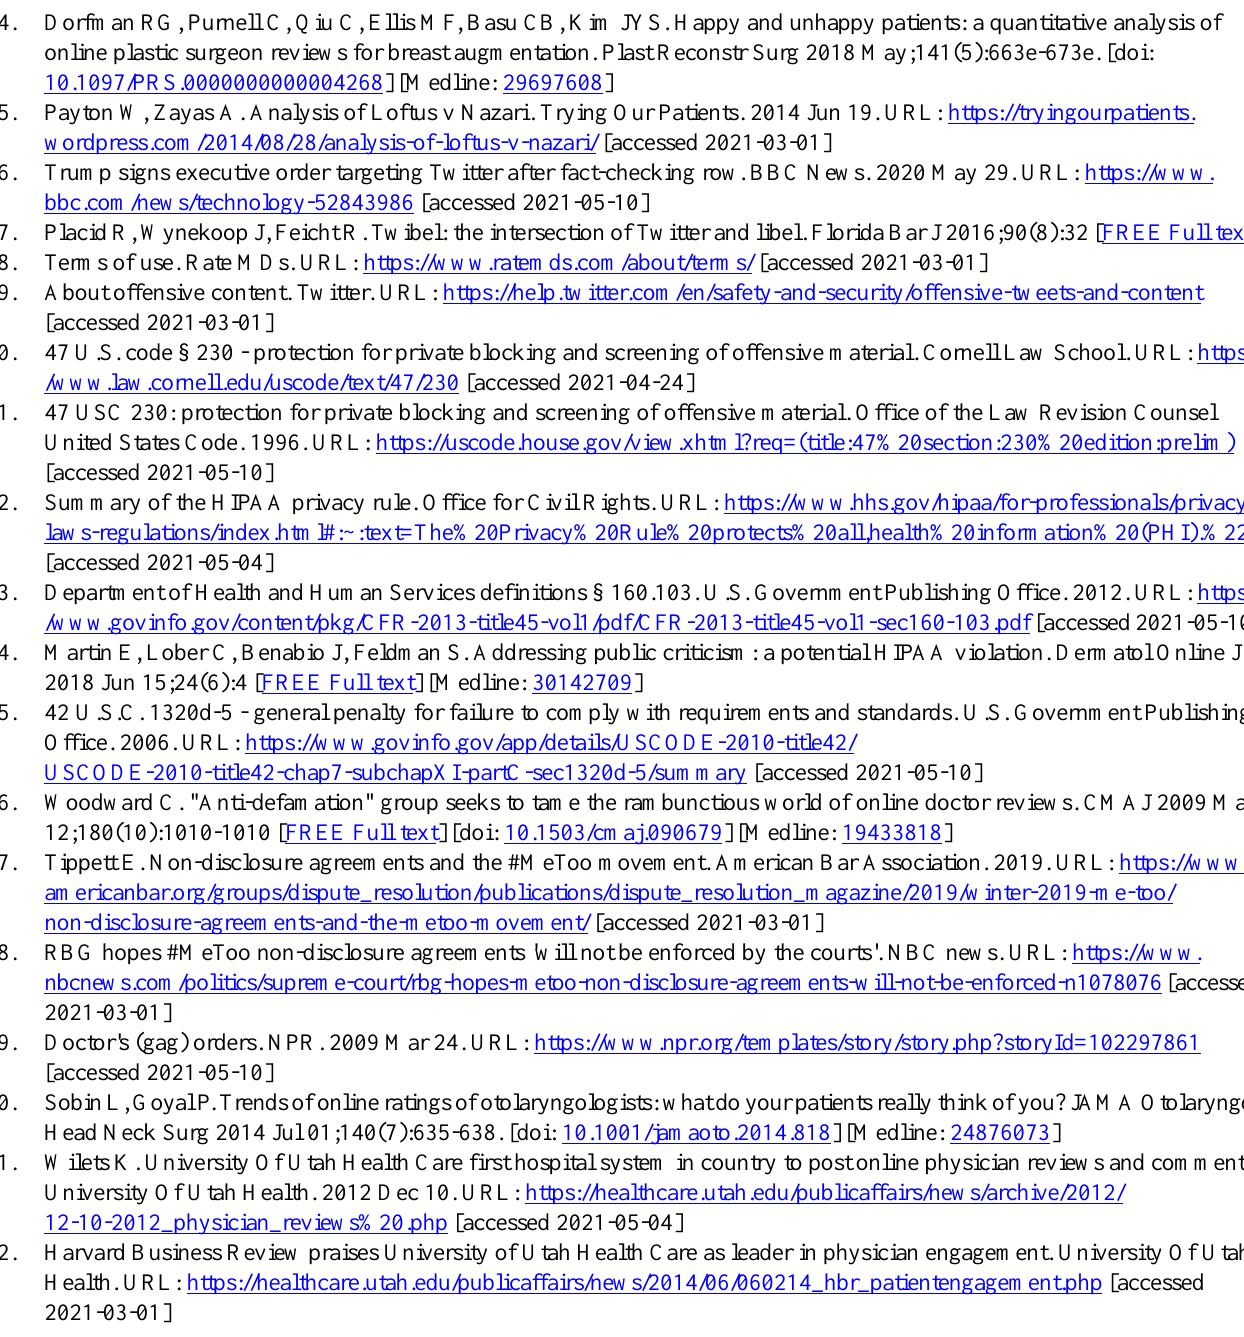
HIPAA: Health Insurance Portability and Accountability Act NDA: nondisclosure